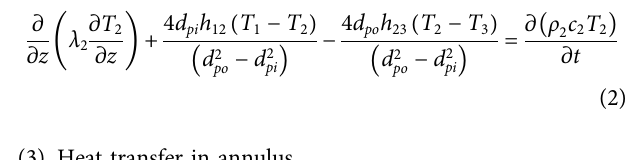
Frontiers in Energy Research |